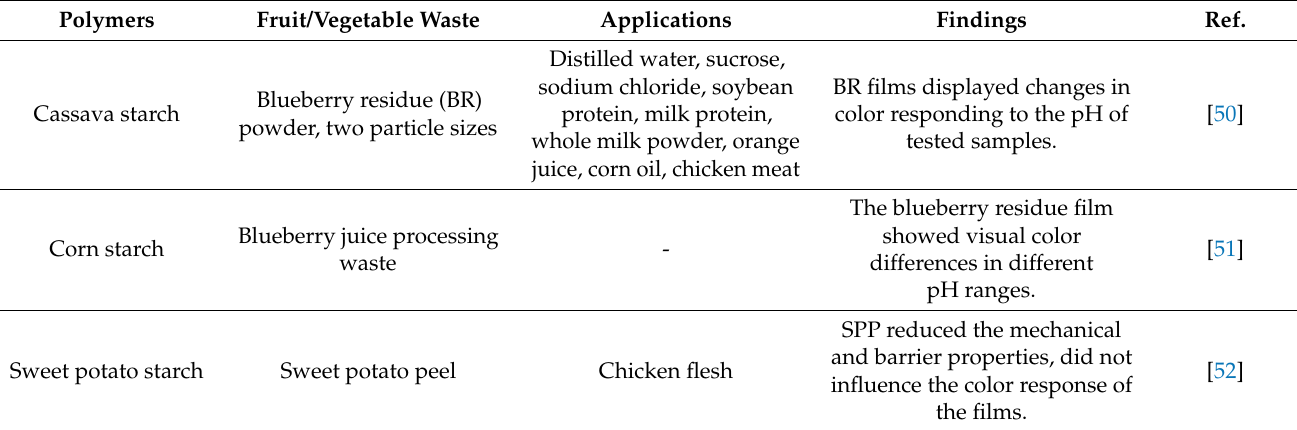
Table 2. Utilization of fruit and vegetable wastes as pH indicator in packaging films.